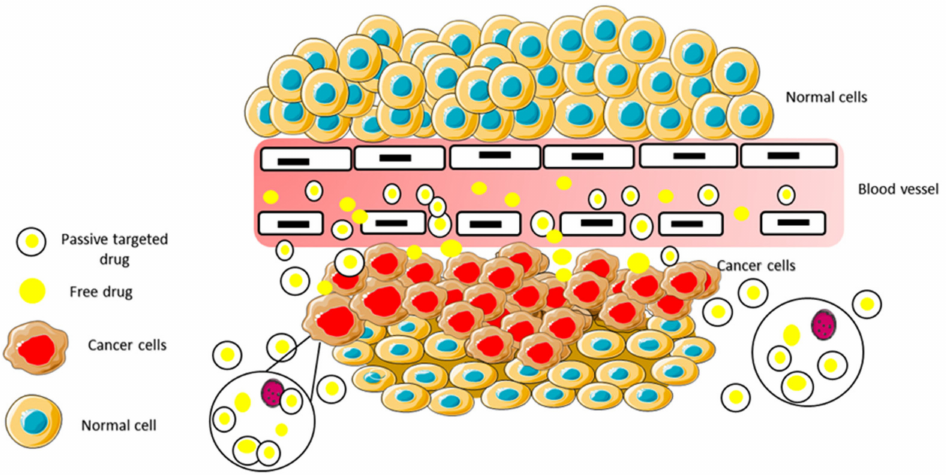
Figure 10. Passive targeting of cancer cells using nanoparticles via leaky